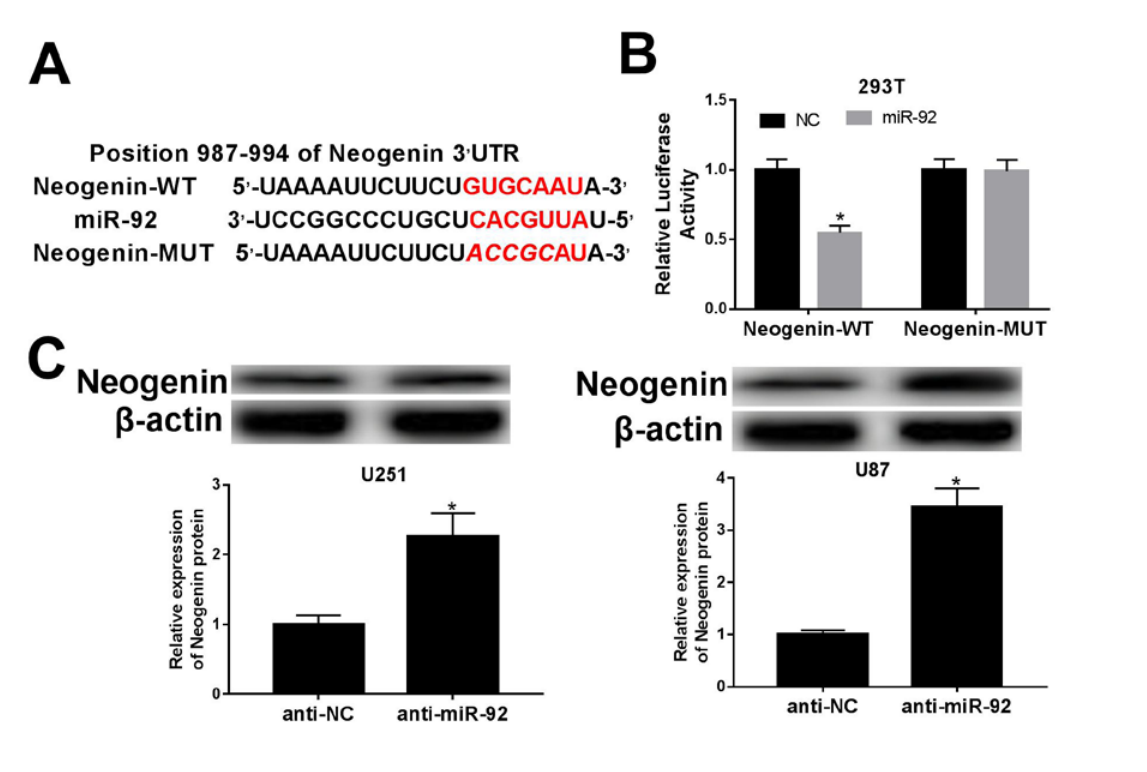
Figure 3: Neogenin directly interacted with miR-92. (A) The putative binding sites of miR-92 and neogenin were predicted by Bioinformatics analysis. (B) Luciferase activity was evaluated in 293T cells co-transfected with wild type of Neogenin 3’UTR (Neogenin-WT) or its mutant (Neogenin-MUT) and miR-92 mimic (miR-92) or its negative control (NC). (C) Neogenin protein level was examined by western blot assay in U251 and U87 cells transfected with miR-92 inhibitor (anti-miR-92) or its control (anti-NC). β-actin was applied as internal reference. *P <